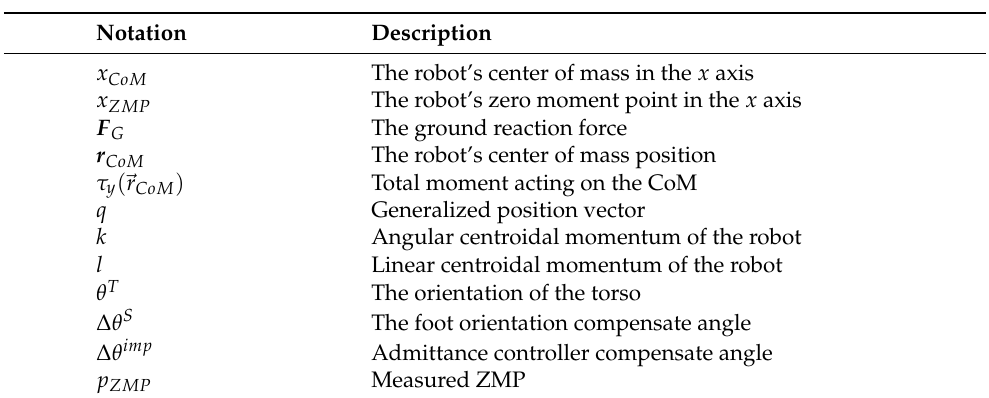
Table 1. Table for